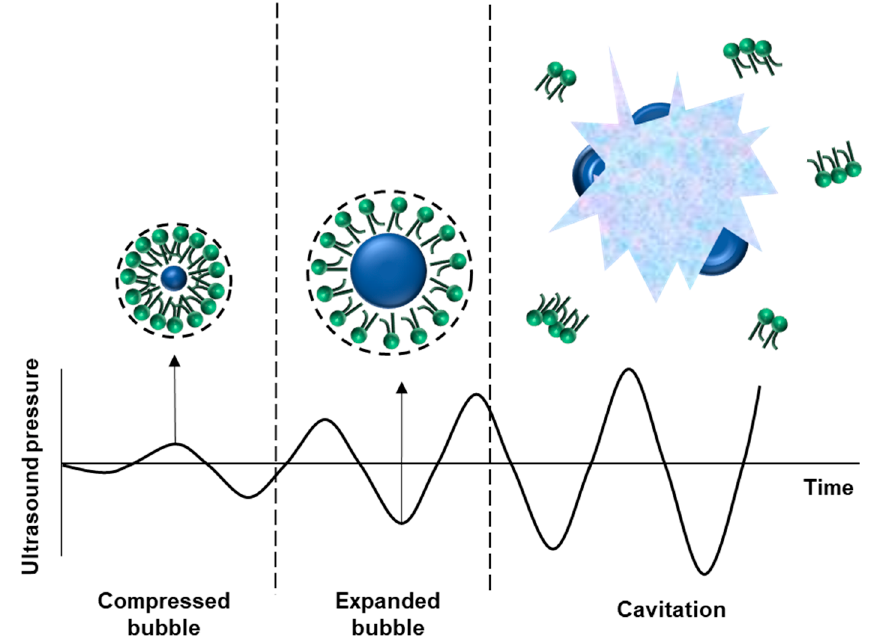
Figure 2. State of the nanobubble in the ultrasonic field. When the bubble enters the ultrasonic field, it oscillates. If frequency overcomes the threshold, cavitation occurs.